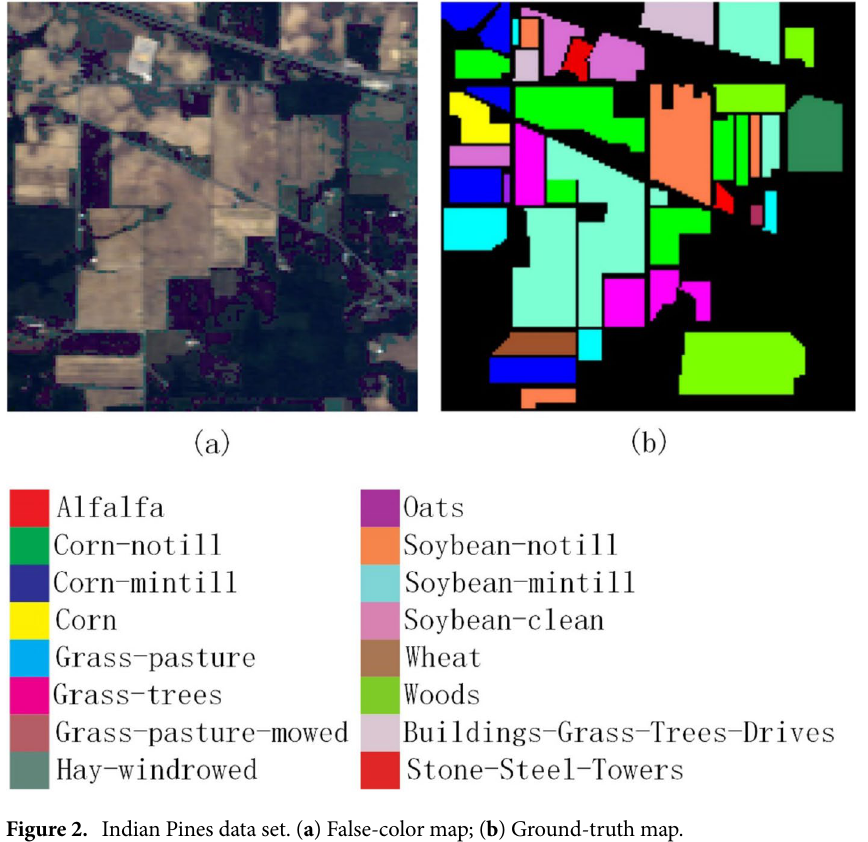
Figure 2. Indian Pines data set. ( a ) False-color map; ( b ) Ground-truth map.